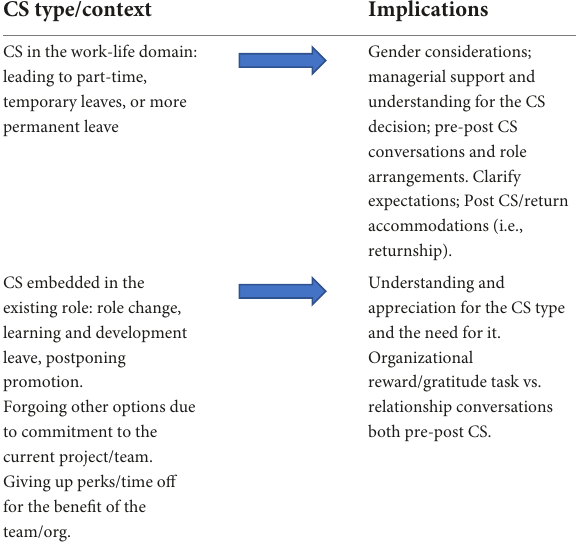
TABLE 2 CS in organizations: Managerial implications. CS type/context